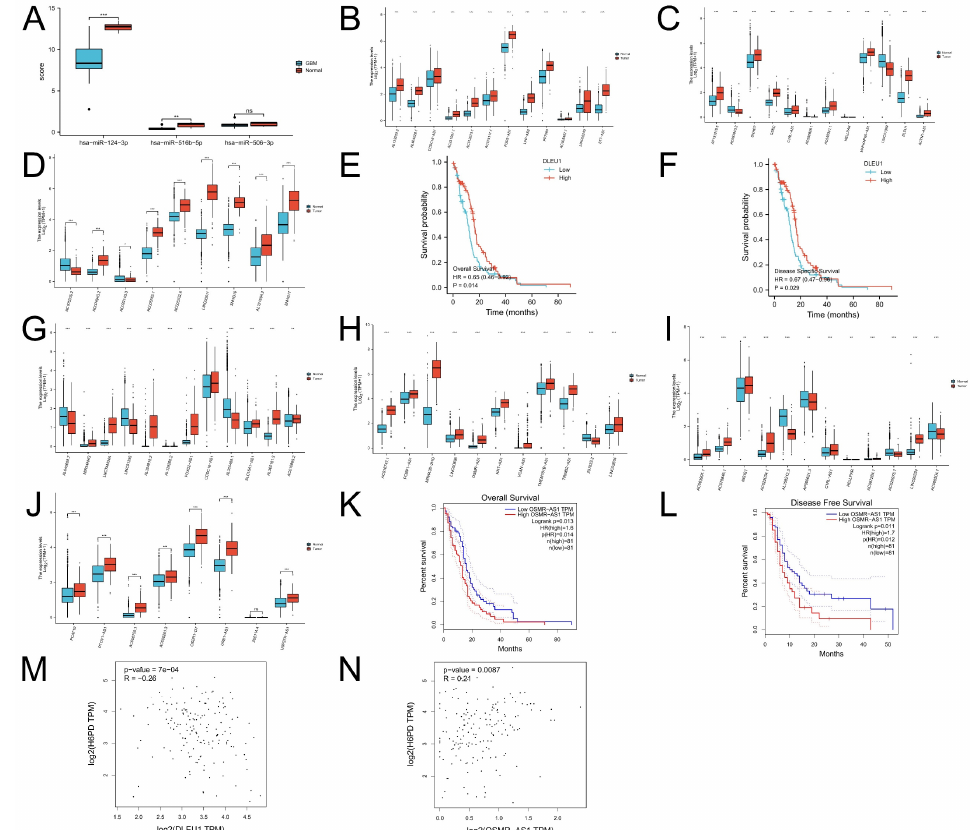
Figure 3. Expression, survival analysis, correlation of candidate miRNAs, lncRNAs, and H6PD. To ascertain whether some lncRNAs modulated H6PD, the upstream miRNAs bound to H6PD were predicted, and finally, three miRNAs, namely hsa-miR-124-3p, hsa-miR-516b-5p, and hsa-miR-506- 3p, were found ( A ). Downregulation of hsa-miR-124-3p and hsa-miR-516b-5p was detected from GSE90603, while downregulation of hsa-miR-506-3p was not. Twenty-seven candidate lncRNAs related to hsa-miR-124-3p were upregulated in GBM ( B – D ). DLEU1 was significantly associated with prognosis in GBM patients, while the other 26 lncRNAs were not ( E , F ). OS and DFS analyses demon- strated that GBM patients with higher DLEU1 expression had a good clinical prognosis. Thirty-five candidate lncRNAs related to hsa-miR-516b-5p were upregulated in GBM ( G – J ). Statistical signifi- cance of OSMR-AS1 for predicting prognosis of GBM was detected, while statistical significance of the other 34 lncRNAs was not ( K , L ). GBM patients with higher OSMR-AS1 expression were negatively associated with OS and RFS. DLEU1 was negatively correlated with H6PD ( M ), while OSMR-AS1 was positively correlated with H6PD ( N ). (ns: no significance; * p -value < 0.05; ** p -value < 0.01; *** p value <